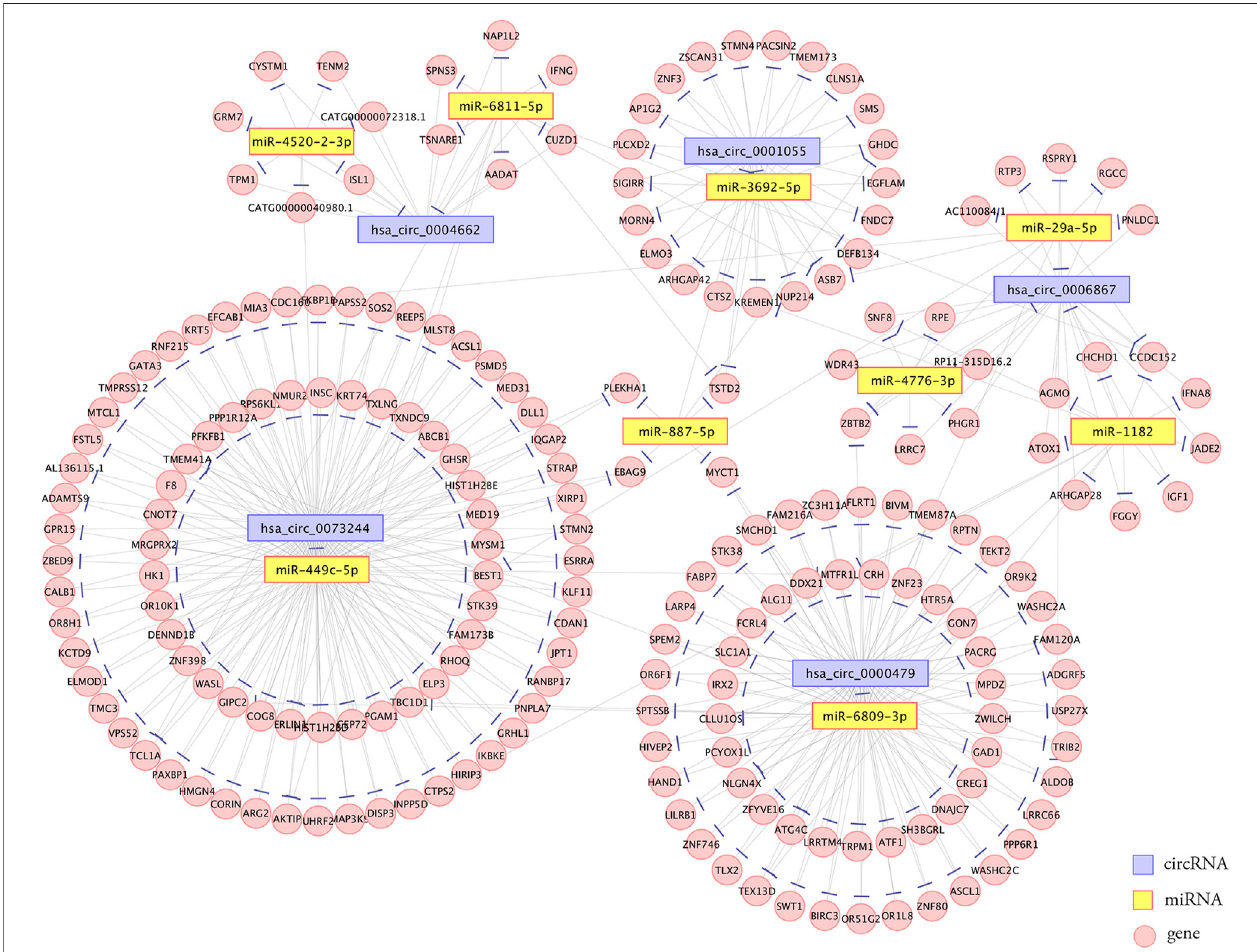
FIGURE 6 | Establishment of the circRNA-miRNA-mRNA interaction network. The network contained fi ve dysregulated circRNAs, nine miRNAs, and 235 correlated mRNAs. EdgeswithT-shaped arrows represent directed relationships. Nodes with purple, yellow, and pink colorrepresentcircRNAs, miRNAs, and mRNAs,